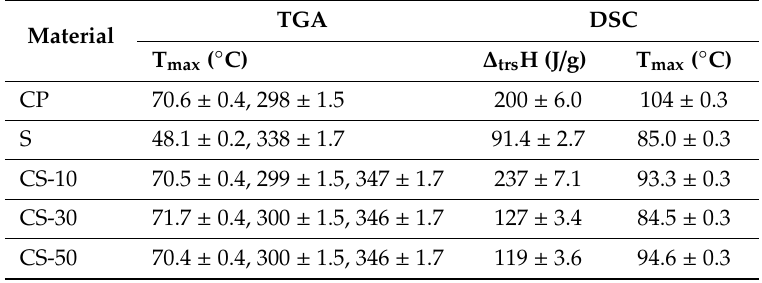
Figure 3. ( a ) Weight loss (%) and ( b ) di ff erential thermal analysis (DTA) plots (weight loss / ◦ C Figure 3 . ( a ) Weight loss (%) and ( b ) differential thermal analysis (DTA) plots (weight loss/ °C vs. temperature) vs. temperature) derived from thermal gravimetric analysis (TGA) for CP, S, CS-10, CS-30, derived from thermal gravimetric analysis (TGA) for CP, S, CS-10, CS-30, and CS-50 samples. and CS-50 samples. Table 1. Thermal properties from thermal gravimetric analysis (TGA) and differential scanning Table 1. Thermal properties from thermal gravimetric analysis (TGA) and di ff erential scanning calorimetry (DSC) for the materials. calorimetry (DSC) for the materials.